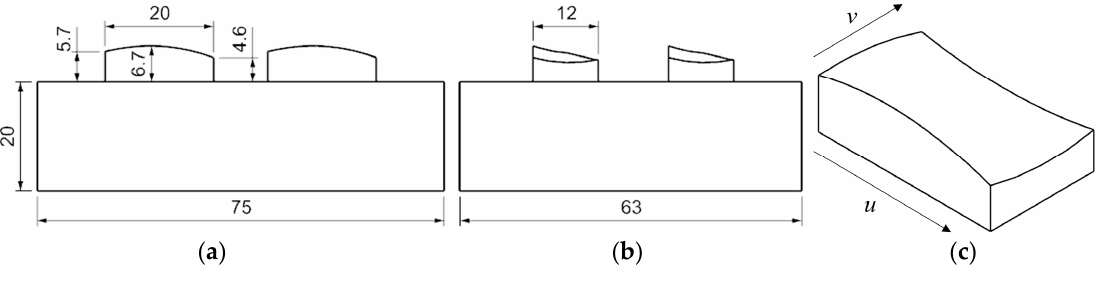
Figure 4. Design of Surface three; ( a ) front view; ( b ) side view; ( c ) isometric view.